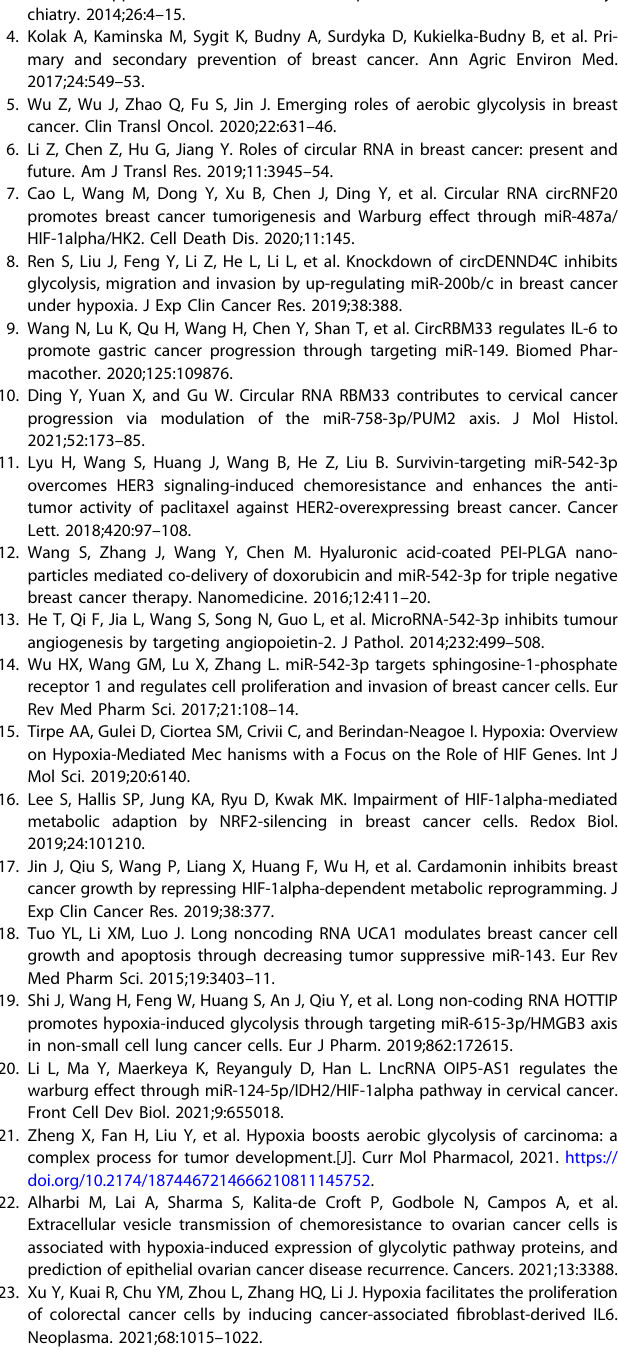
Fig. 7 Overexpression of HIF-1 α reverses the inhibitory effect of upregulated miR-542-3p on glycolysis and apoptosis of BCa cells. A , B HIF-1 α expression in MCF-7 cells after upregulating miR-542-3p and HIF-1 α ; C Glucose consumption in MCF-7 cells after upregulating miR-542- 3p and HIF-1 α ; D Lactate production in MCF-7 cells after upregulating miR-542-3p and HIF-1 α ; E Western blot detected HK2, LDHA and GLUT1 expression in MCF-7 cells after upregulating miR-542-3p and HIF-1 α ; F CCK-8 detected MCF-7 cell proliferation after upregulating miR-542-3p and HIF-1 α ; G Flow cytometry detected MCF-7 cell apoptosis after upregulating miR-542-3p and HIF-1 α (Under normoxia, after upregulating miR-542-3p, the apoptotic rate increased from 7.28% to 16.88%, and after upregulating miR-542-3p and HIF-1 α , the apoptotic rate decreased from 17.25% to 9.14%; Under hypoxia, after upregulating miR-542-3p, the apoptotic rate increased from 3.20% to 7.88%, and after upregulating miR-542-3p and HIF-1 α , the apoptotic rate decreased from 8.50% to 3.340%); * P < 0.05. Data were expressed in the form of mean ± standard deviation (Repetitions = 3). The comparison among multiple groups should be performed by one-way ANOVA, while pairwise comparison was by Tukey ’ s